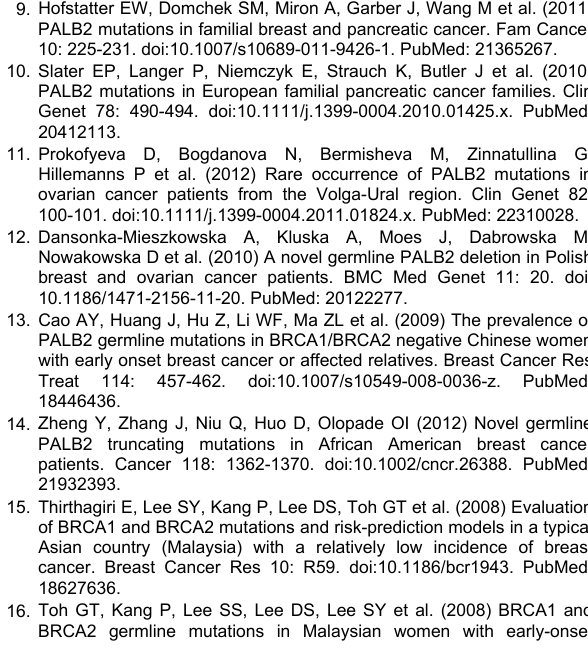
Table S1. Amplification primers used for the sequencing of PALB2 gene.